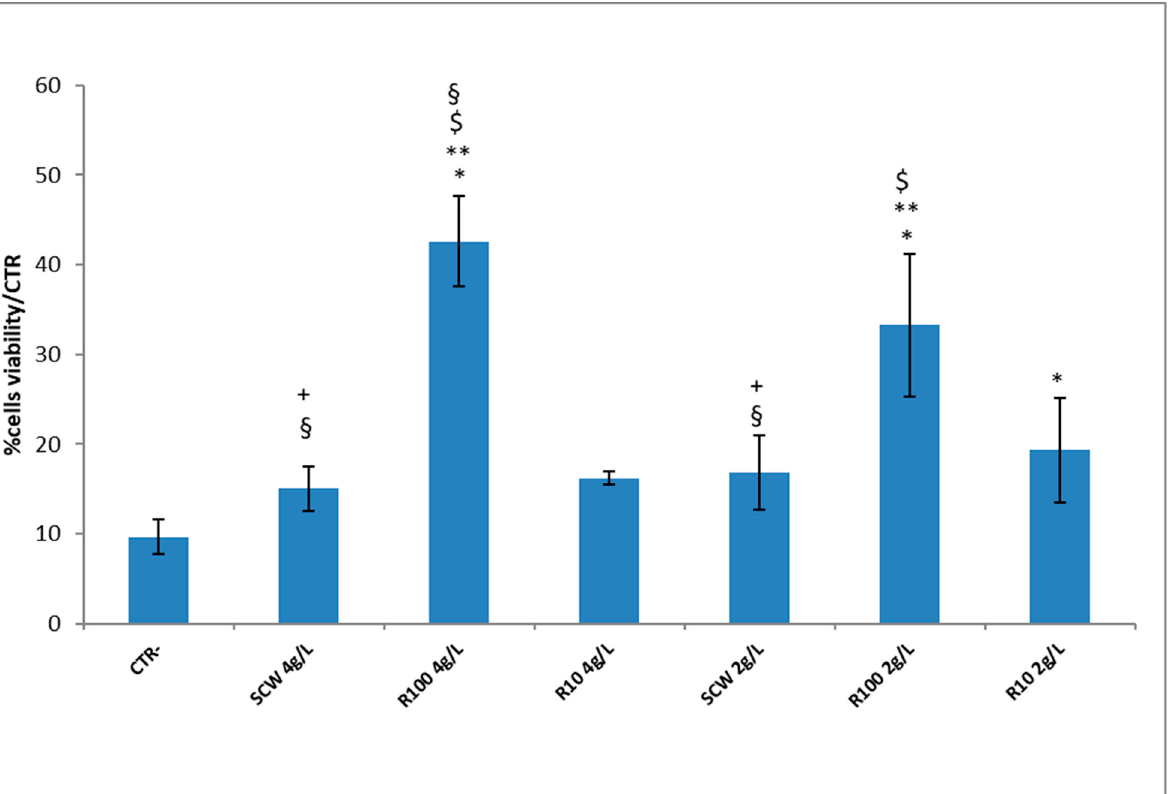
Figure 7. Cell viability after dehydration. * p < 0.05 vs. CTR-, ** p < 0.01 vs R10 2 g/L, $ p < 0.01 vs. R10 2 g/L, § p < 0.005 vs. R100 2 g/L, + p < 0.05 vs. whey R10 4 g/L.